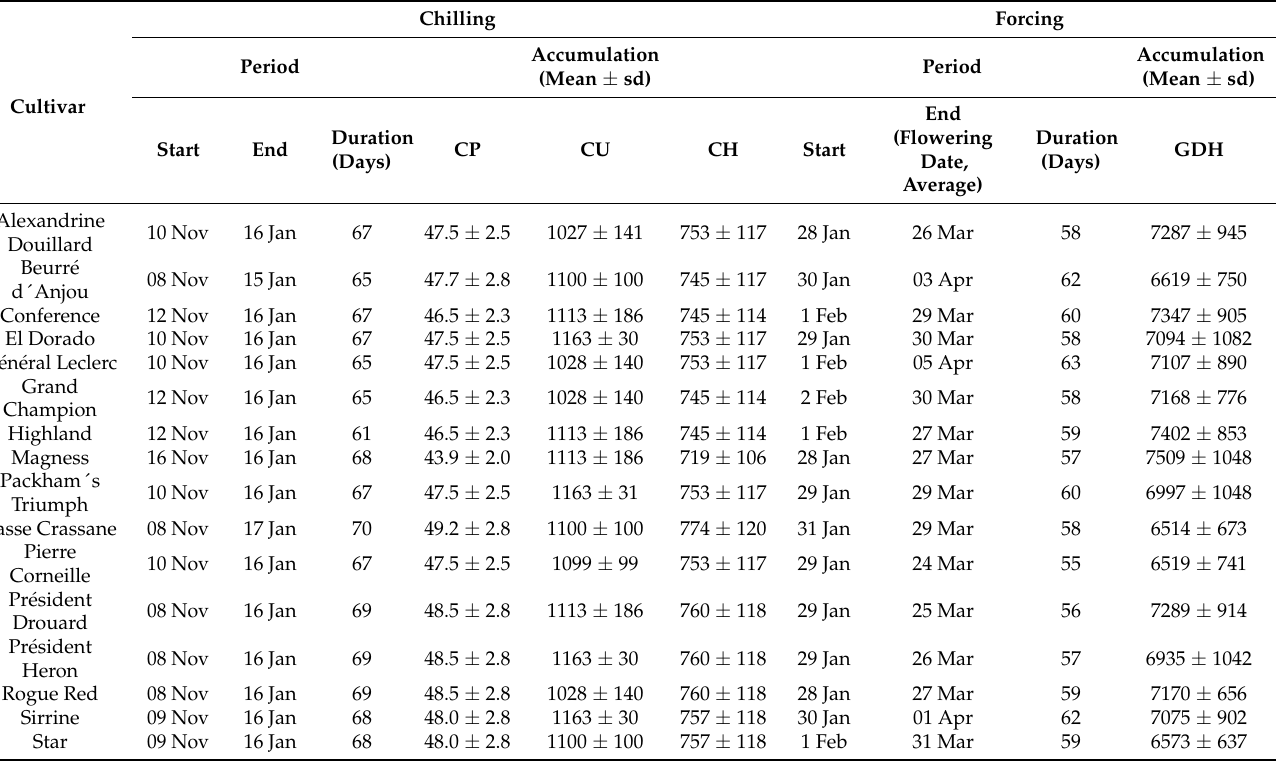
Table 2. Average chilling and forcing periods and agroclimatic requirements (mean ± standard deviation) estimated for 16 pear cultivars grown in Zaragoza (Spain) in the 20-year interval 1986–1989, 1992–2007, and 2022. Chill requirements were computed according to the Dynamic (in CP), Chilling Hours (in CH), and Utah (in CU) models. The Growing Degree Hours model (in GDH) was used to estimate heat